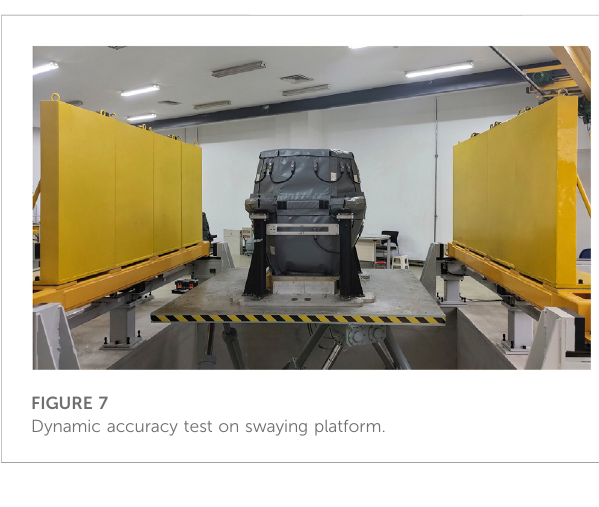
FIGURE 7 Dynamic accuracy test on swaying platform.